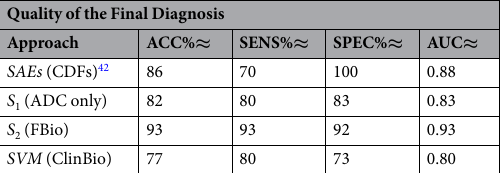
Table 4. Comparative diagnostic quality between the first scenario ( S 1 ) using the ADC maps alone with the CNN-based classification system, the second scenario ( S 2 ) utilizing the fusion of the clinical biomarkers and the image markers using the same CNN-based classification system as well, the clinical biomarkers (ClinBio) based on using a support vector machine (SVM) classifier, and the classification using the CDFs of the ADCs obtained from the segmented kidney based on using stacked auto-encoders (SAEs) 42 in terms of accuracy (ACC%), sensitivity (SENS%), specificity (SPEC%), and area under the curve (AUC) for the combined/fused decision from all of the individual